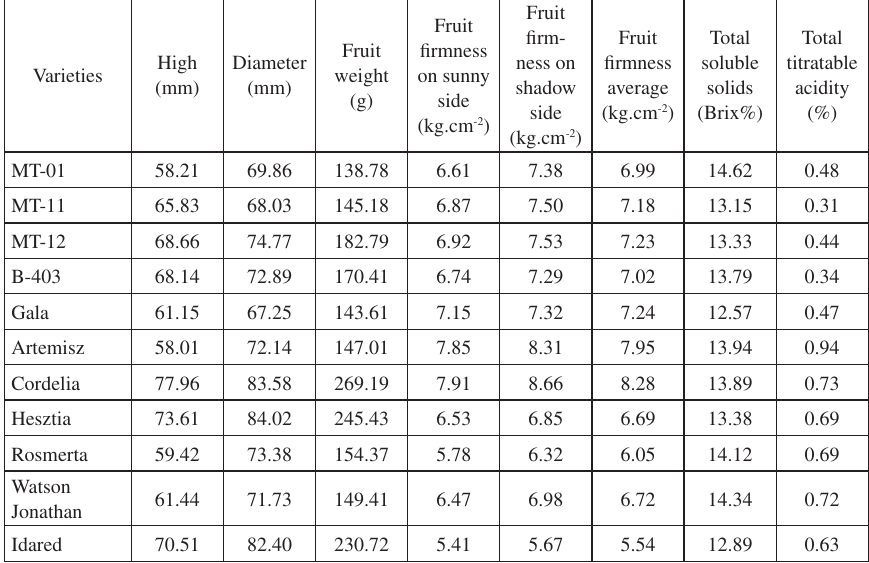
Table 1. High, diameter, mass, fi rmness, refraction and total acid values of apple varieties in 5 years average (2007–2011)